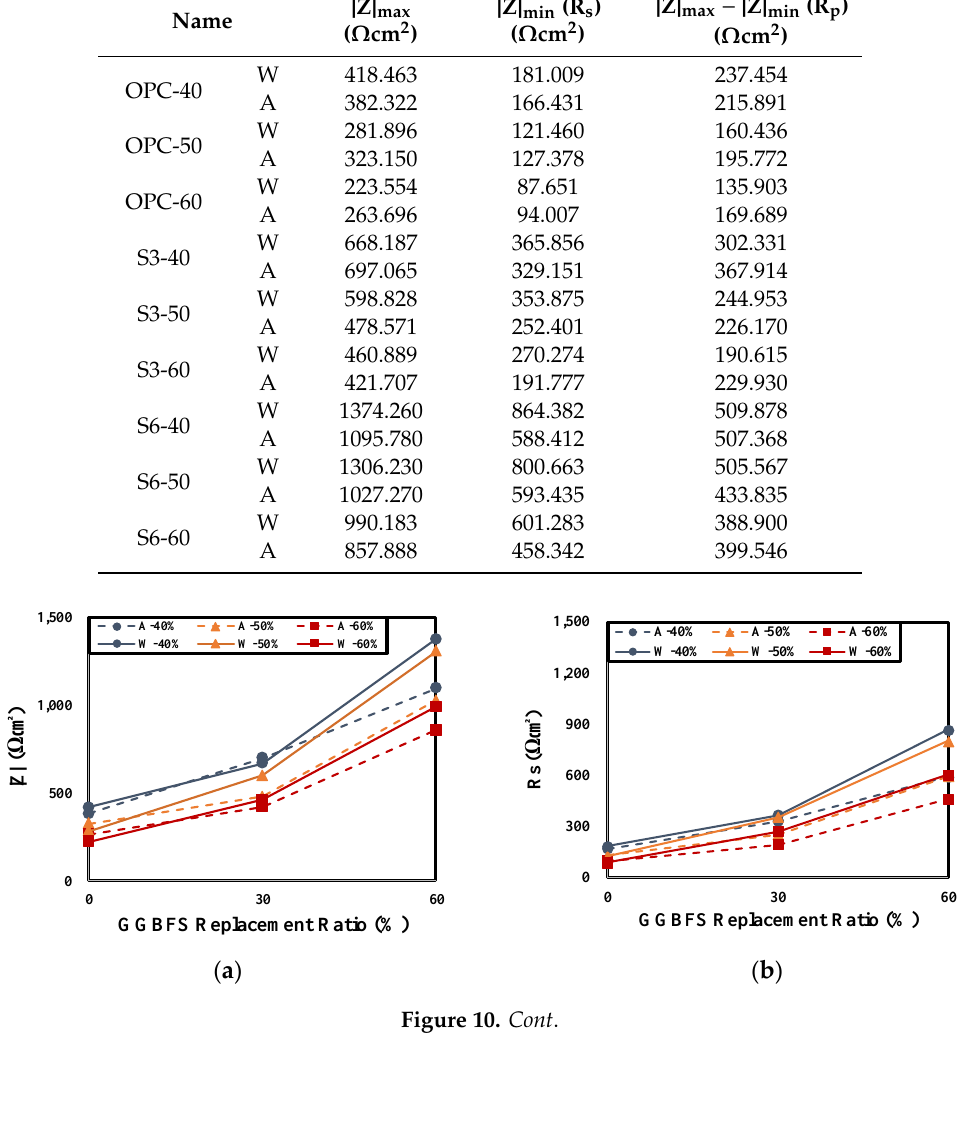
Table 7. Result of EIS according to curing condition.